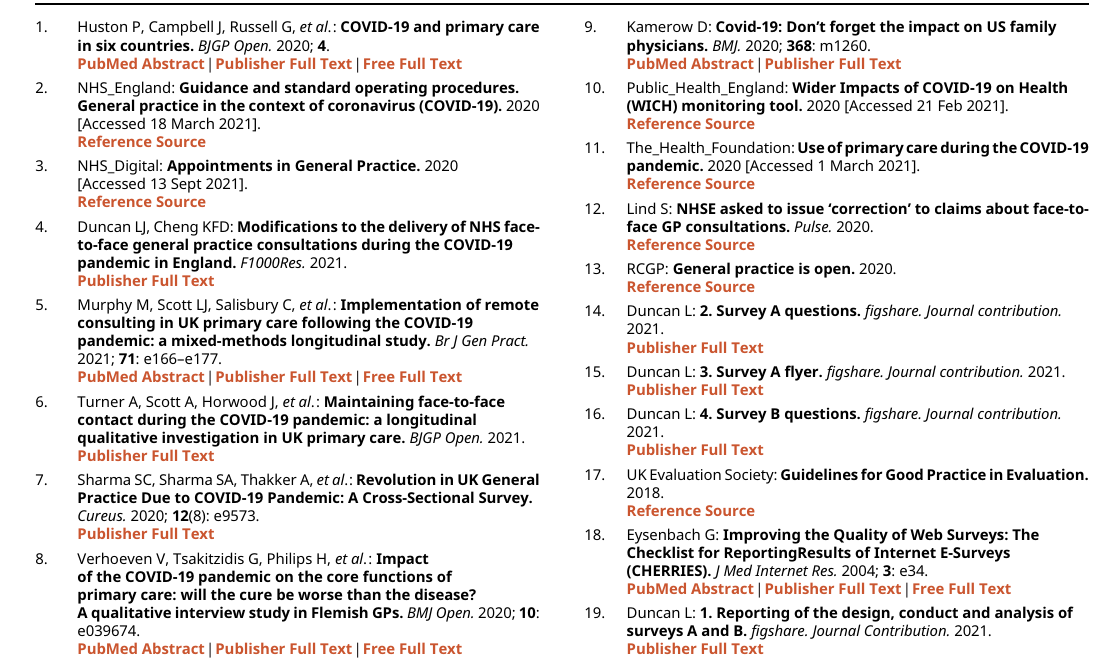
Figshare: Reporting of the design, conduct and analysis of surveys A and B, https://doi.org/10.6084/m9.figshare. 14269454.v1